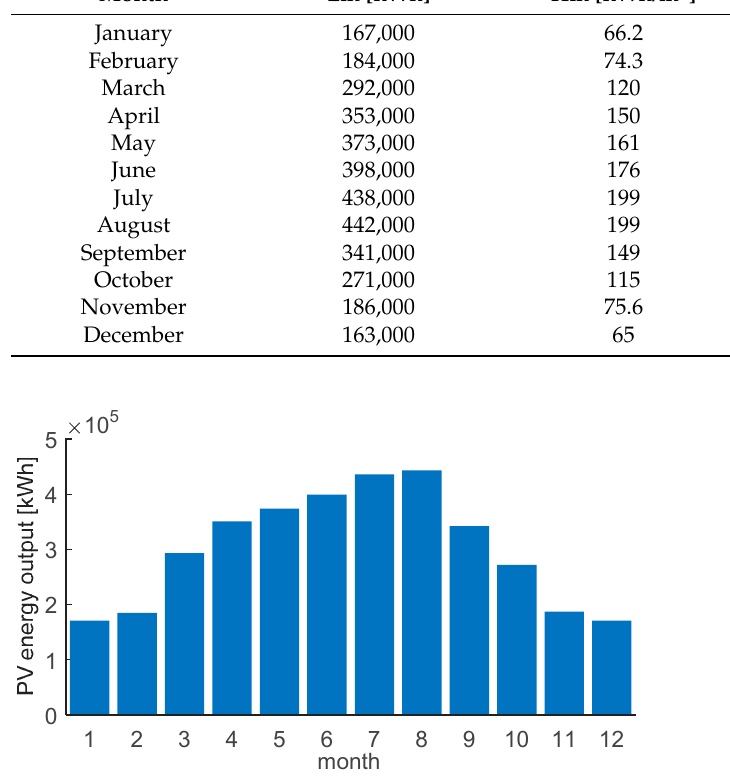
Figure 10. The average electricity production from a 3 MW photovoltaic plant per month.